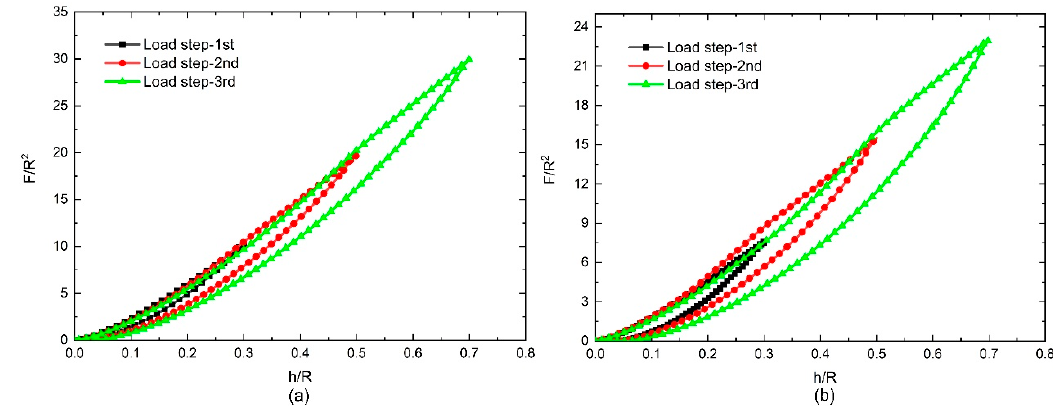
Figure 5. Test results for the nanoparticle-filled polyurethanes (NPFPUs) subjected to cyclic compressive load: ( a ) filled with 5 parts per hundred resin (phr) carbon black (CB); ( b ) filled with 10 phr CB. Figure 4. Test results for the nanoparticle-filled polyurethanes (NPFPUs) subjected to cyclic compressive load: ( a ) filled with 5 parts per hundred resin (phr) nano-silica; ( b ) filled with 10 phr nano-silica.